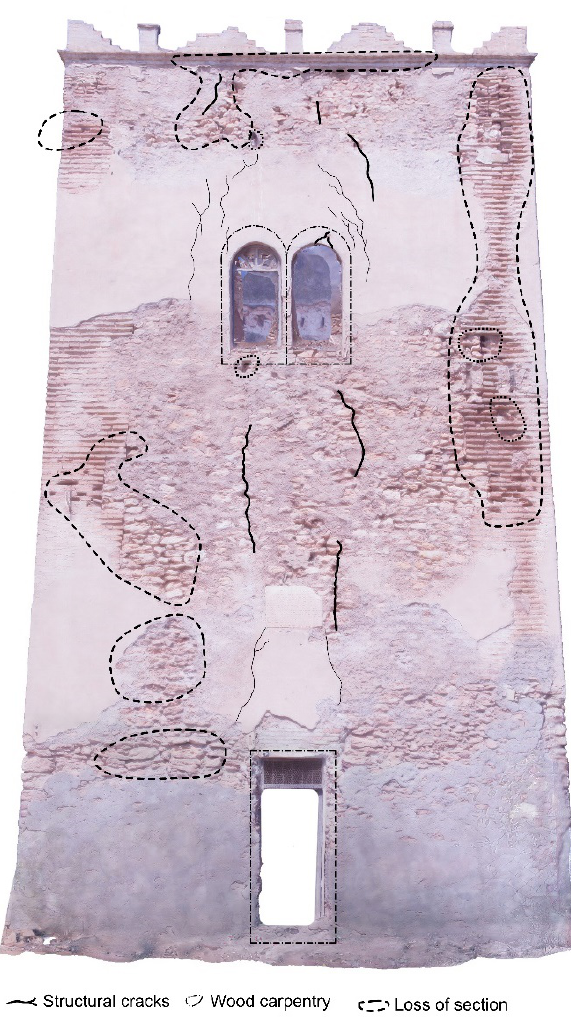
Figure 7. Study of pathologies of south façade of the Negro Tower. Current State. Photogrametry modelling. Own